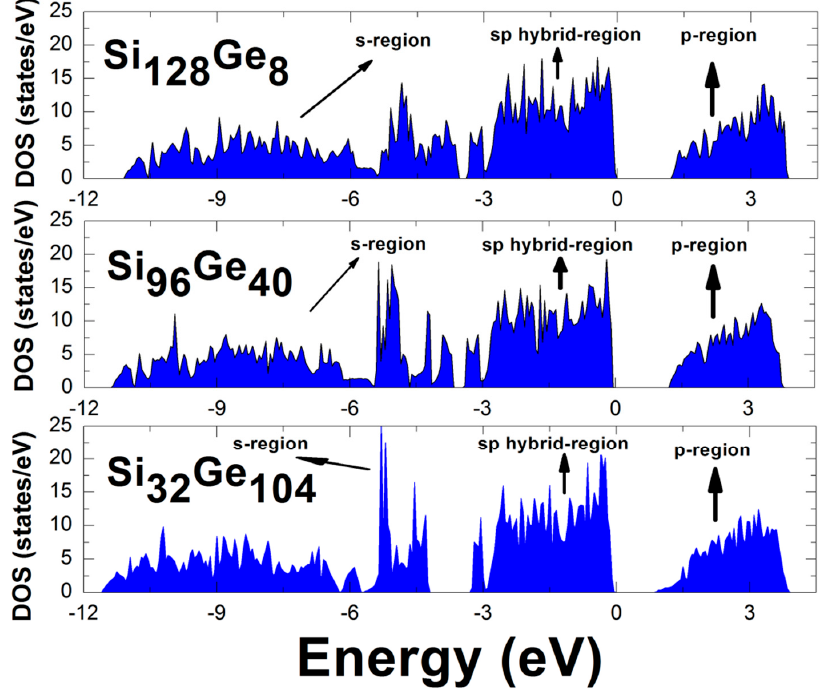
Figure 3. Calculated electronic density of states for Si 136- x Ge x ( x = 8, 40, 104), zero energy is set at the maximum of the valence band.